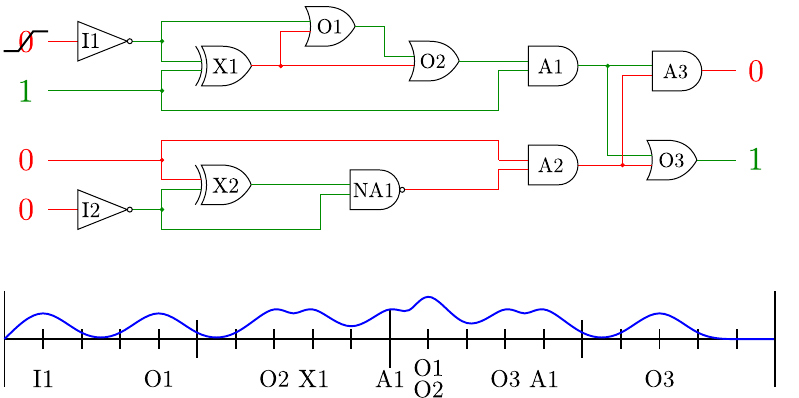
Figure 2: Circuit behavior for exemplary input transition ( p 0 , k 0 , p 1 , k 1 ) = (0 , 1 , 0 , 0) → (1 , 1 , 0 , 0). The timeline shows the occurrence of gate toggles over